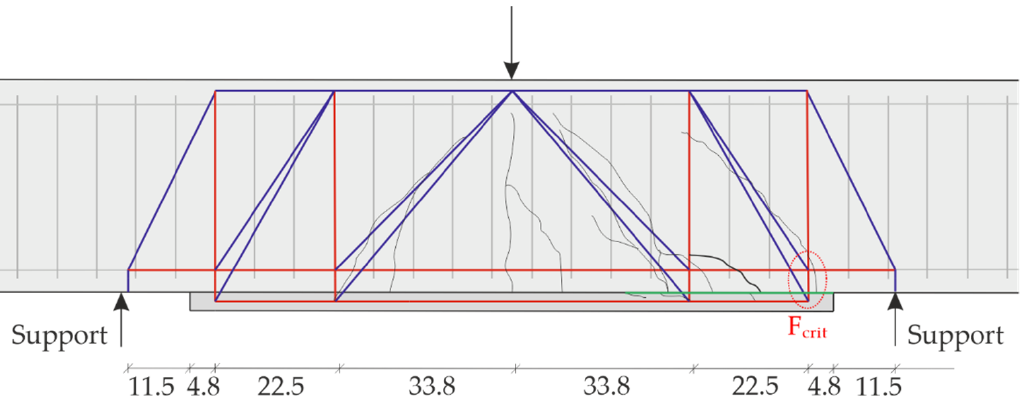
Figure 24. Final crack state and strut-and-tie-model for specimen 1. (Graphic: CARBOCON GMBH).